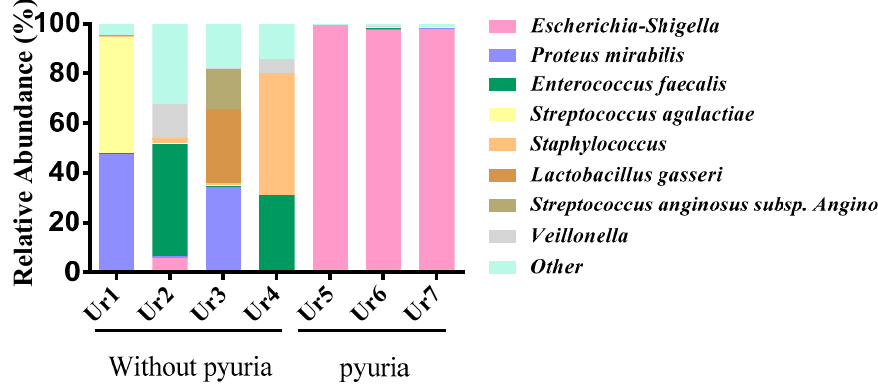
Figure 2. A stacked histogram showing the relative abundance of 16S metagenomic sequences in the urine of T2D patients treated with SGLT2 inhibitors.